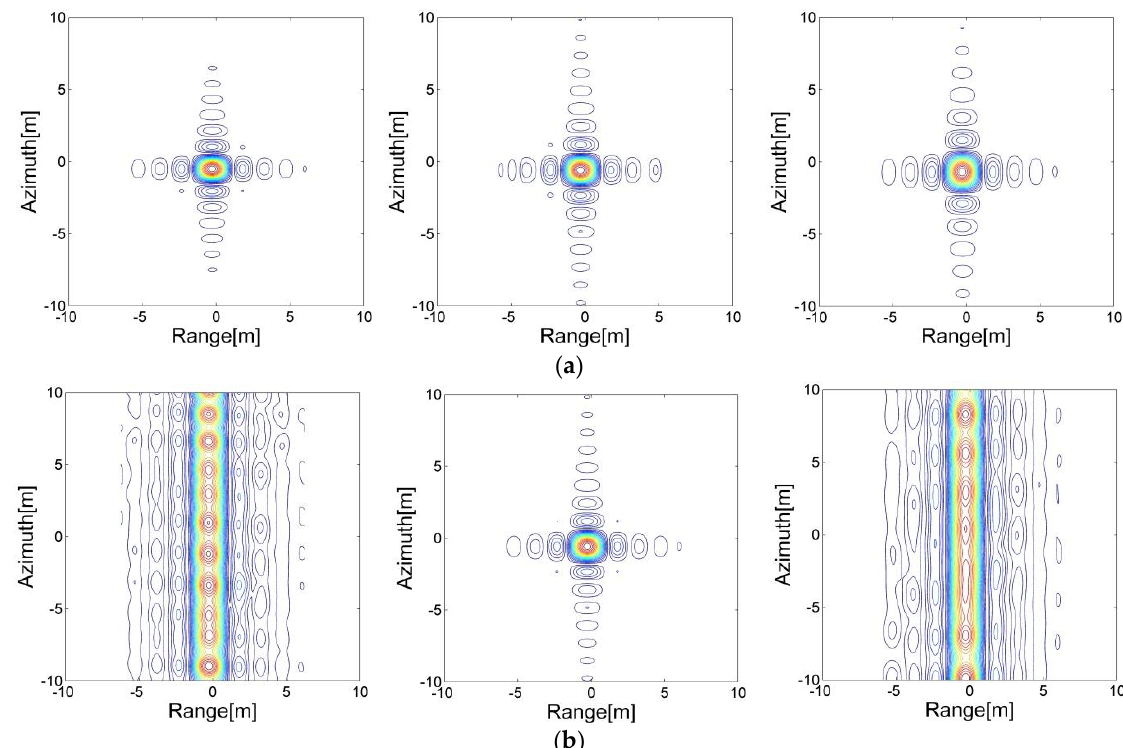
Figure 10. The contour images of the targets P 1 , P 5 , and P 9 , in turn; ( a ) HSHD-AFBP, ( b ) HS-AFBP. Table 4. Focusing performance evaluation of the nine point targets when using HSHD-AFBP.